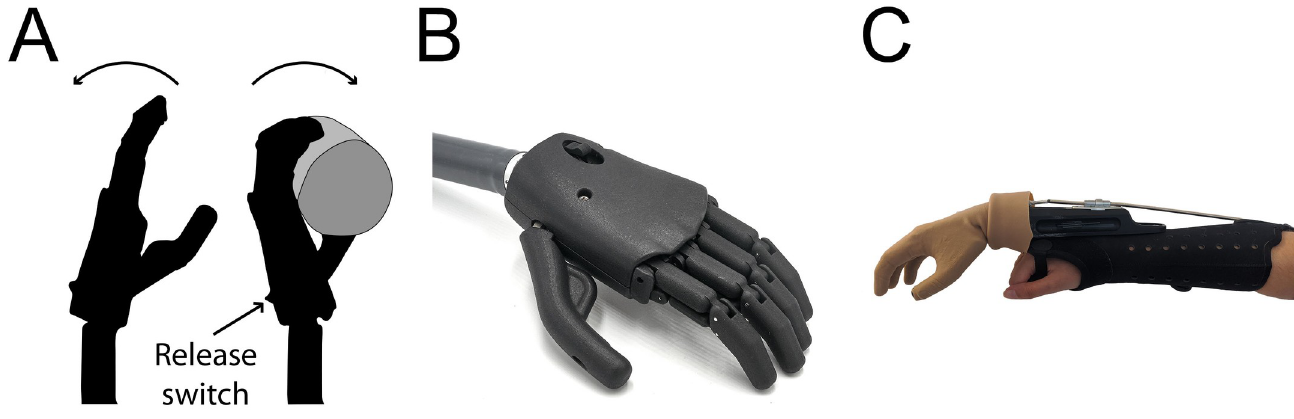
Fig 1. The Self-Grasping Hand. A: As the Self-Grasping Hand is flexed backward at the wrist, the fingers curl around the object. B: Self-Grasping Hand prototype. C: Self-Grasping Hand attached to the TRS simulator forearm brace with a cosmetic glove worn over the hand (Please note that the TRS simulator is designed for use with body-powered prostheses and therefore includes a cable running along the brace. This cable was not attached to the Self-Grasping Hand and was not used during this